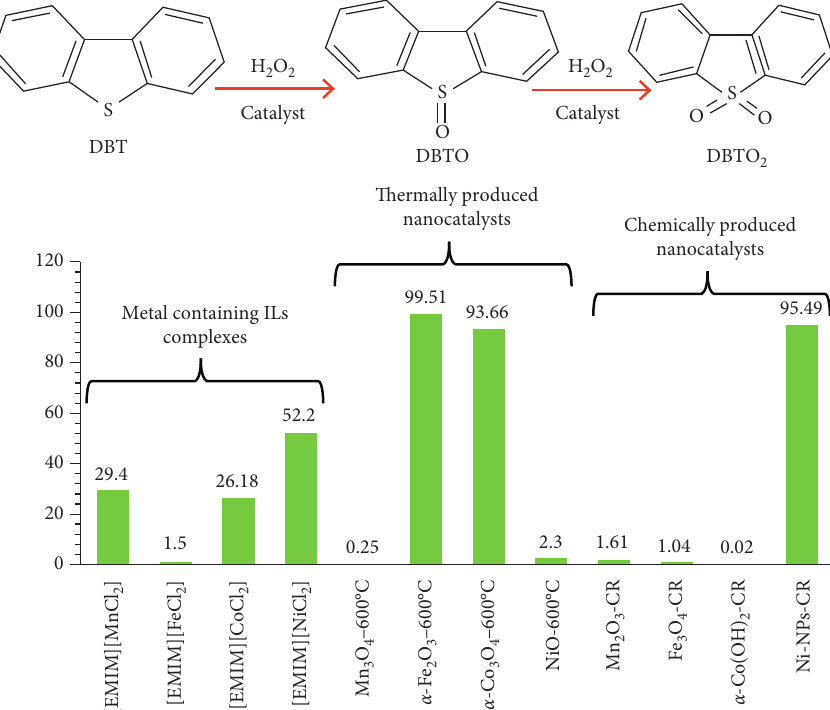
Figure 8: Schematic representation of the overall scheme of the oxidation of dibenzothiophene (DBT) to dibenzothiophene sulfone (DBTO 2 ) and conversion percentage of the products formed by using different